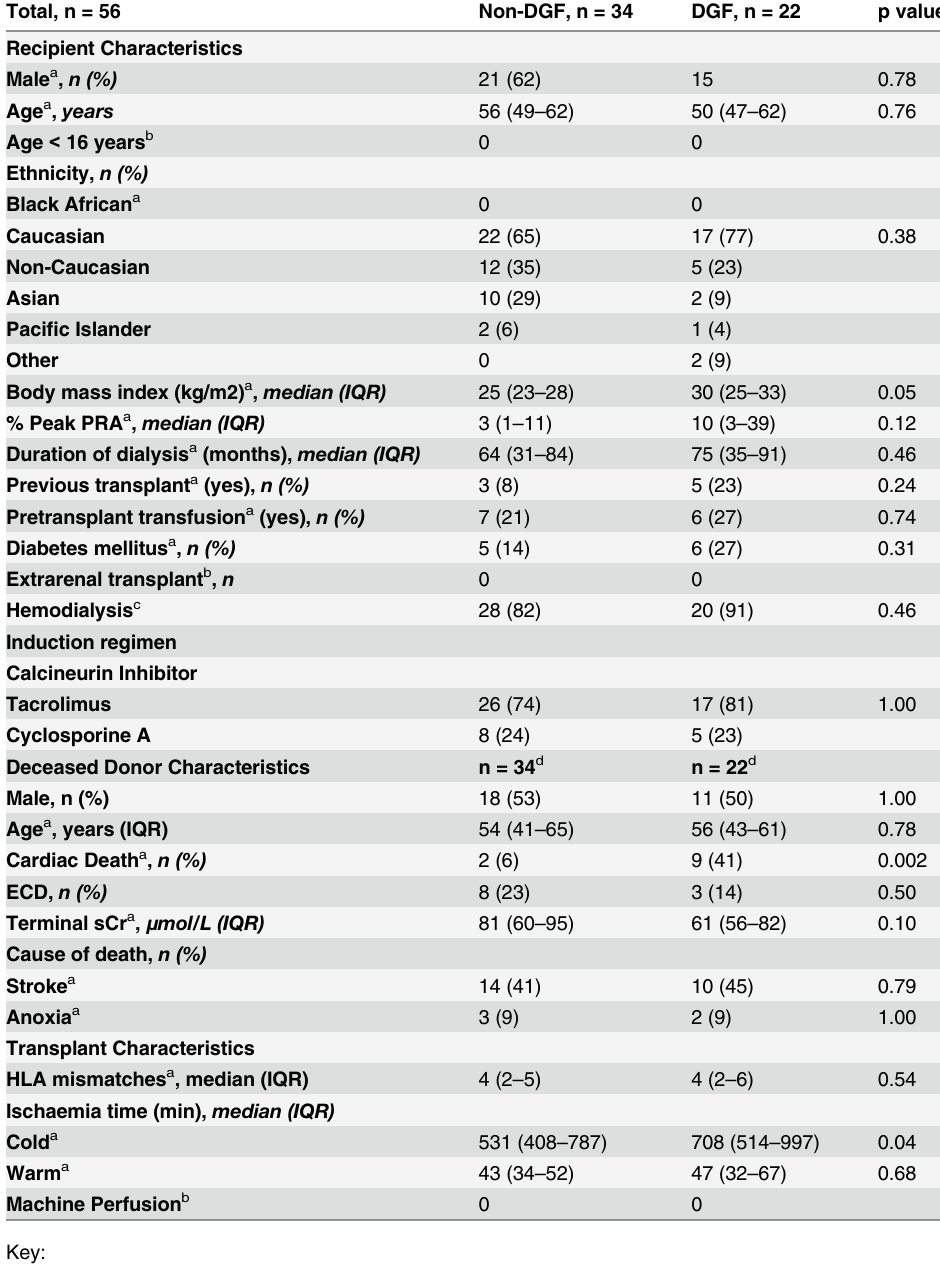
Table 1. Baseline characteristics of transplant recipients and